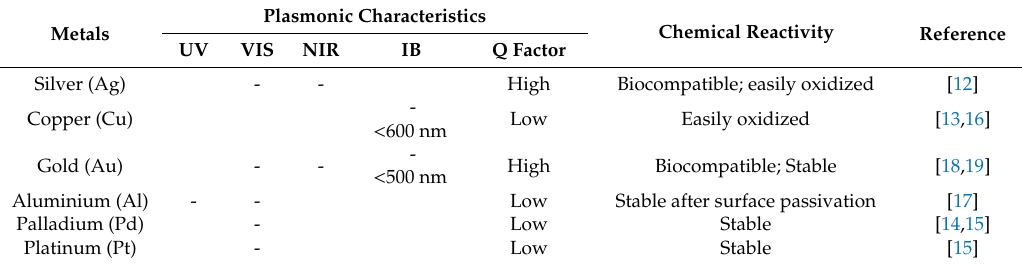
Table 1. Characteristics of various metals used for metal-enhanced fluorescence (MEF) applications.